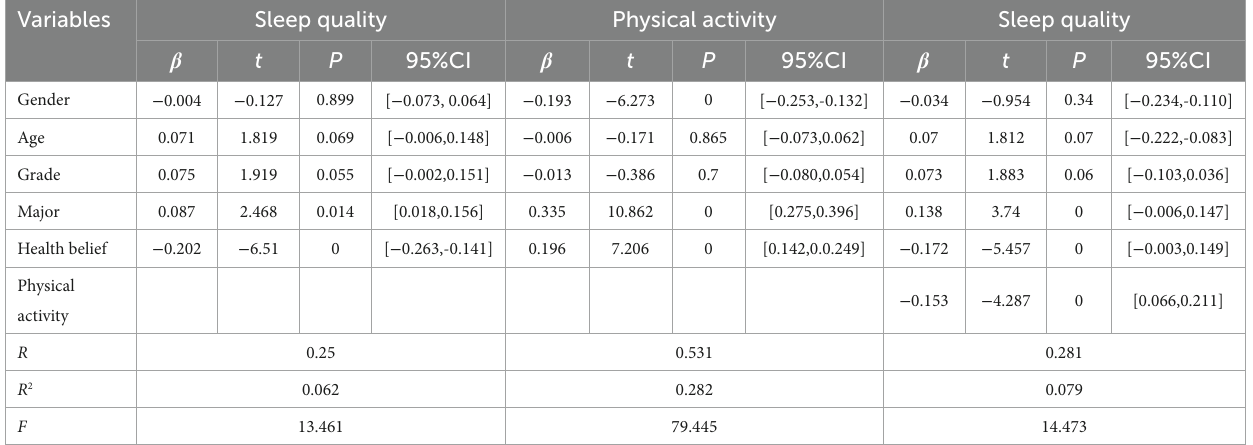
TABLE 3 Mediating effect analysis of physical